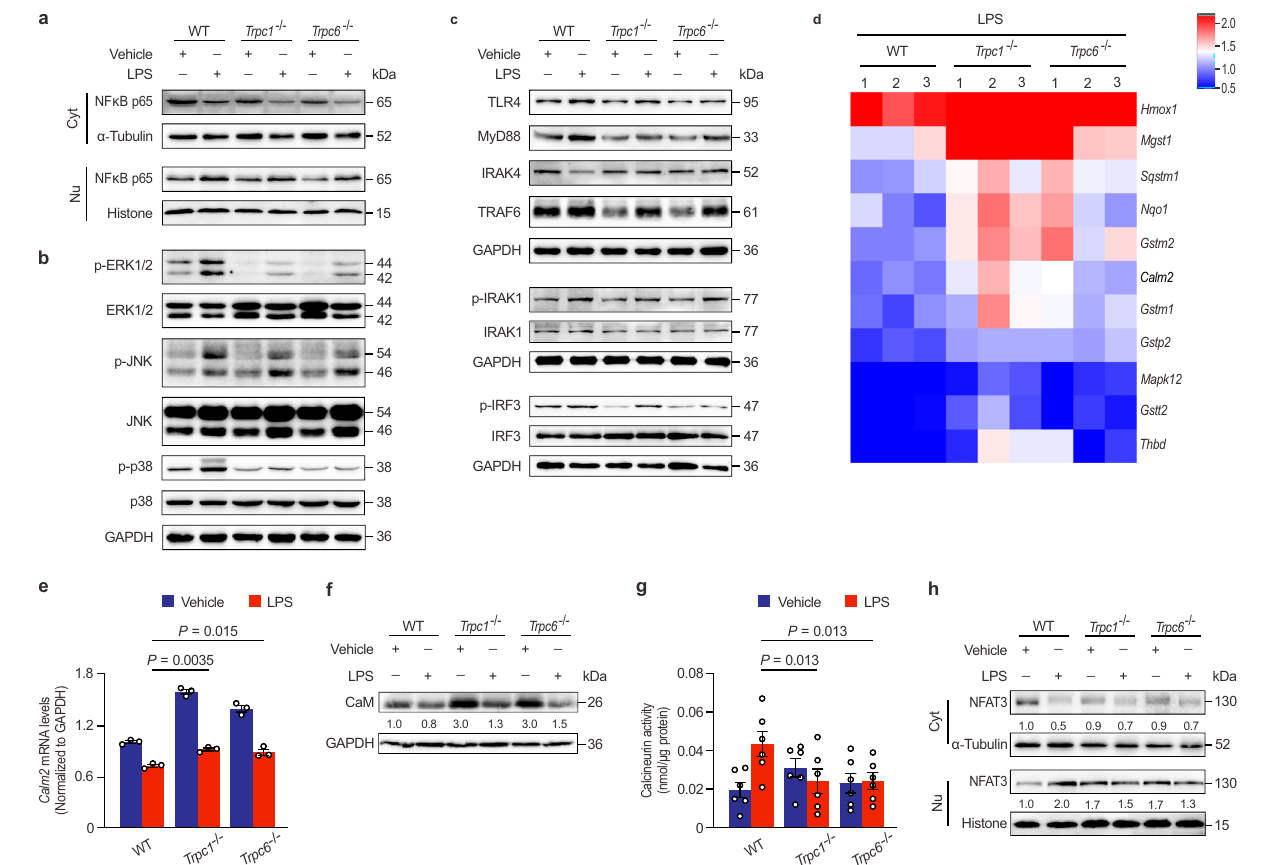
Fig. 3 | TRPC1 and TRPC6 associate with TLR4 andCa 2+ signaling pathways.a-b The effects of Trpc1 or Trpc6 knockout on nuclear factor- κ B (NF- κ B) and mitogen- activatedproteinkinases(MAPK)signaling pathways in the hearts of mice4hafter LPS challenge (pooled tissues from 3 male mice per sample, n =3 biological inde- pendent experiments). c The effects of Trpc1 or Trpc6 knockout on Toll like receptor 4 (TLR4) ‐ mediated myeloid differentiation primary response protein 88 (MyD88)- and TIR domain-containing adaptor inducing IFN- β (TRIF)-dependent signaling pathways in the hearts of mice 4h after LPS challenge (pooled tissues from 3 male mice per sample, n =3 biological independent experiments). d Heatmap depicting the genes involved in the Ca 2+ signaling pathway from the